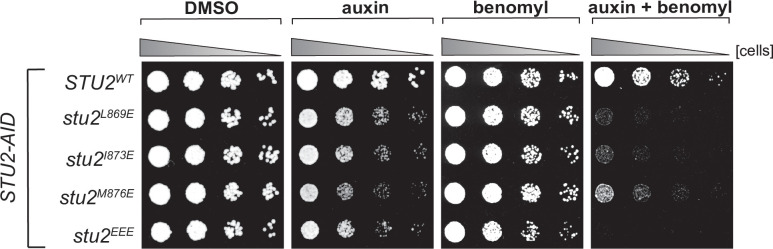
Cell viability assays for single residue hydrophobic-to-charged mutations.STU2-AID cells expressing various STU2-3V5 alleles from an ectopic locus (STU2WT, M622; stu2L869E, M1443; stu2I873E, M1442; stu2M876E, M1441; stu2EEE, M1444) were serially diluted (fivefold) and spotted on plates containing DMSO, 500 μM auxin, 5 μg/mL benomyl or 500 μM auxin + 5 μg/mL benomyl.